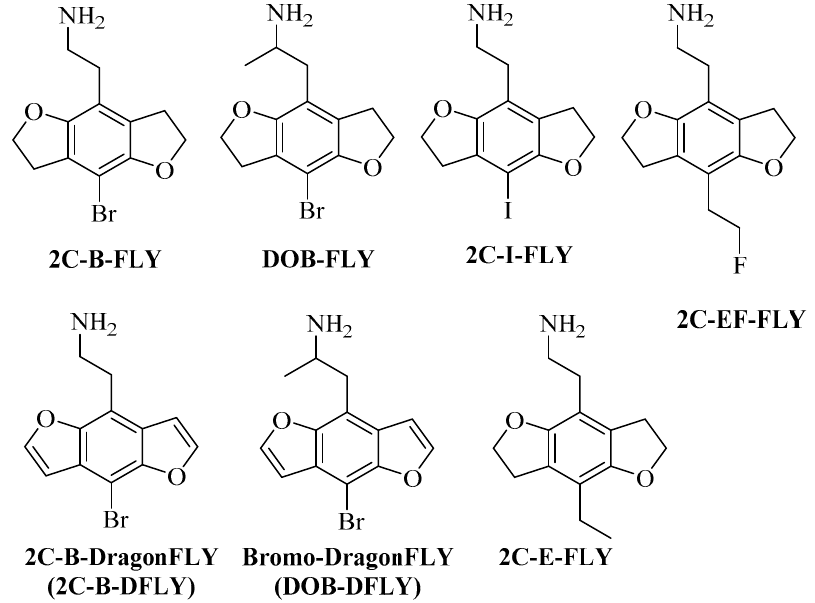
Figure 1. Chemical structures of the phenyl-alkyl-amine hallucinogens 2,5-dimethoxy-4-bromo- phenethylamine (2C-B) and 2,5-dimethoxy-4-bromoamphetamine (DOB), phenethylamine (2C-B) and 2,5-dimethoxy-4-bromoamphetamine (DOB), 2-(8-iodo-2,3,6,7-tetra hydrobenzo[1,2-b:4,5-b`]difuran-4-yl) ethan-1-amine (2C-I-FLY), 2-(8-ethyl-2,3,6,7-tetrahydrobenzo [1,2-b:4,5-b`]difuran-4-yl)ethan-1-amine (2C-E-FLY), 2-[8-2-fluoroethyl)-2,3,6,7-tetrahydrobenzo[1,2- b:4,5-b`]difuran-4-yl]ethan-1-amine (2C-EF-FLY), also their benzodifuran and tetrahydrobenzodi-